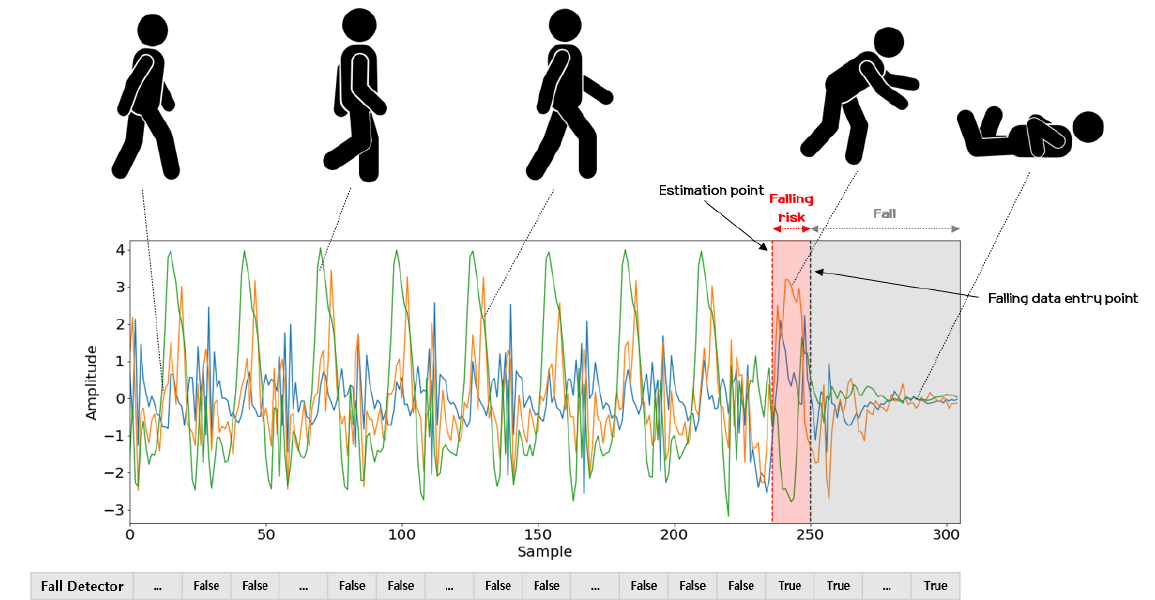
Figure 27. Results of fall detection experiments. The estimation point can be used as a point in time to transmit an indicator that informs the user in advance that a fall may occur when the fall detector detects a potential fall, by means of the FNO predictive results for the next time step data. After that, when actual fall data is entered, it can be viewed as a fall